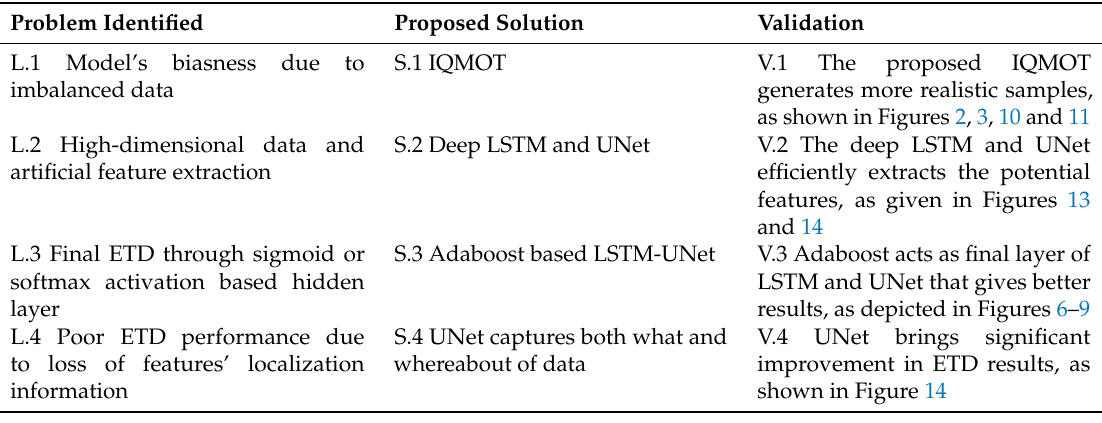
Table 9. Mapping between the identified problems, proposed solution and